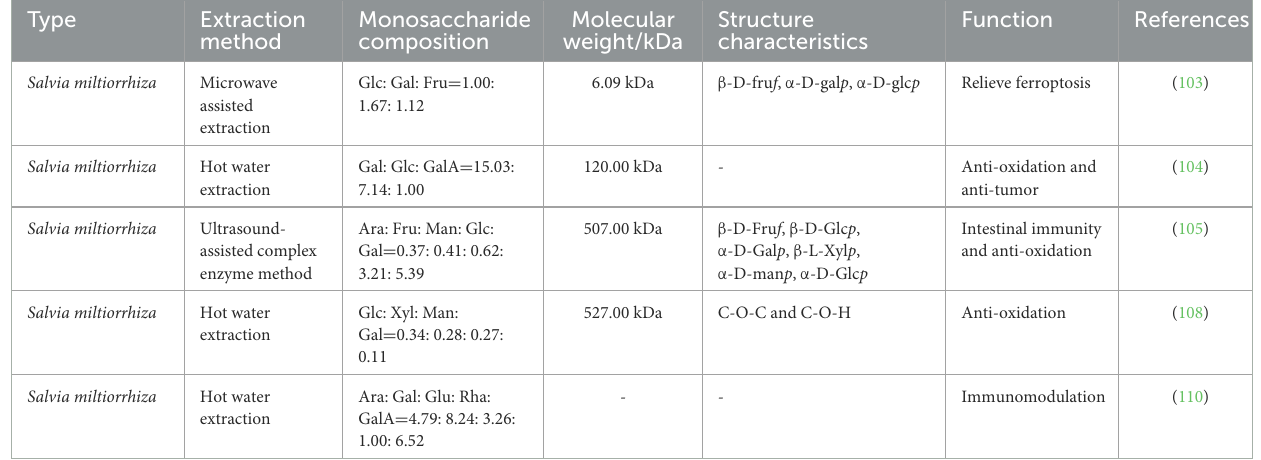
TABLE 6 Structure and structure-activity-relationship of polysaccharide from Salvia miltiorrhiza .